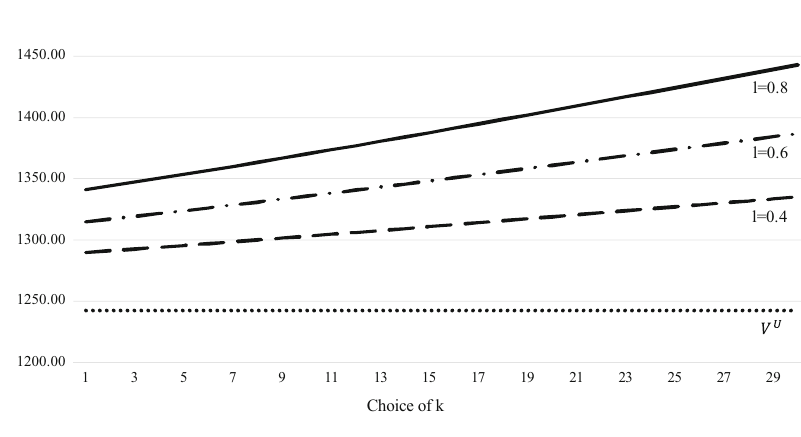
Fig. 2 V L dependent on k for four different t